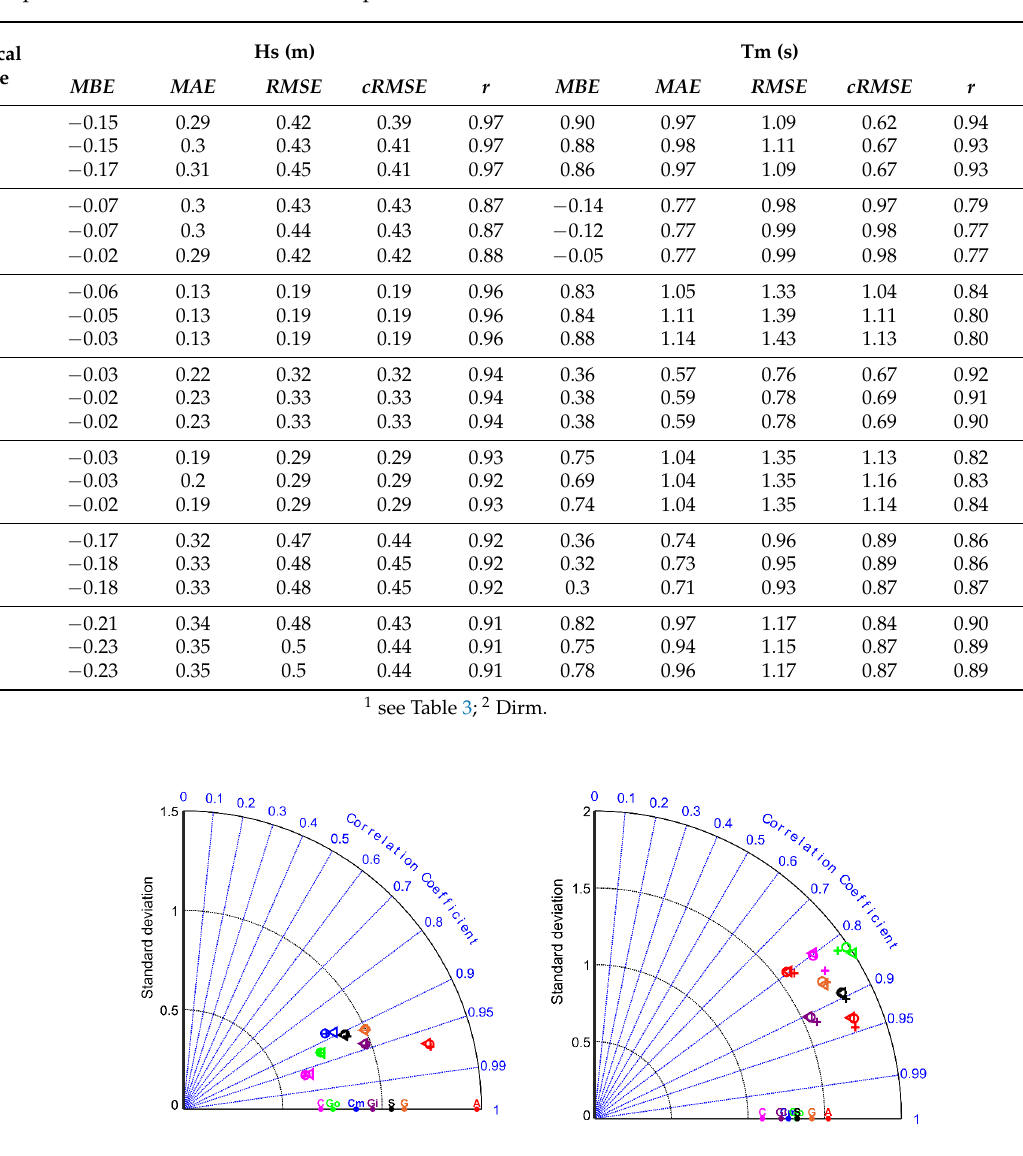
Table 6. Statistical indicators for Hs, Tm and Dirp (or Dirm), evaluated for explicit N, PSI and FCT numerical schemes, with ST4 source term parameterization and 60 s time step.